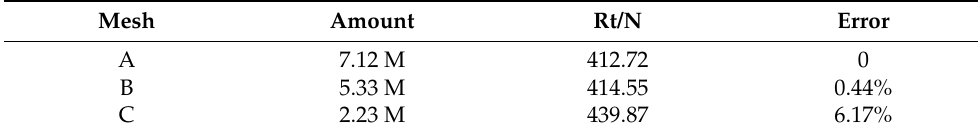
Table 3. Mesh convergence verification.